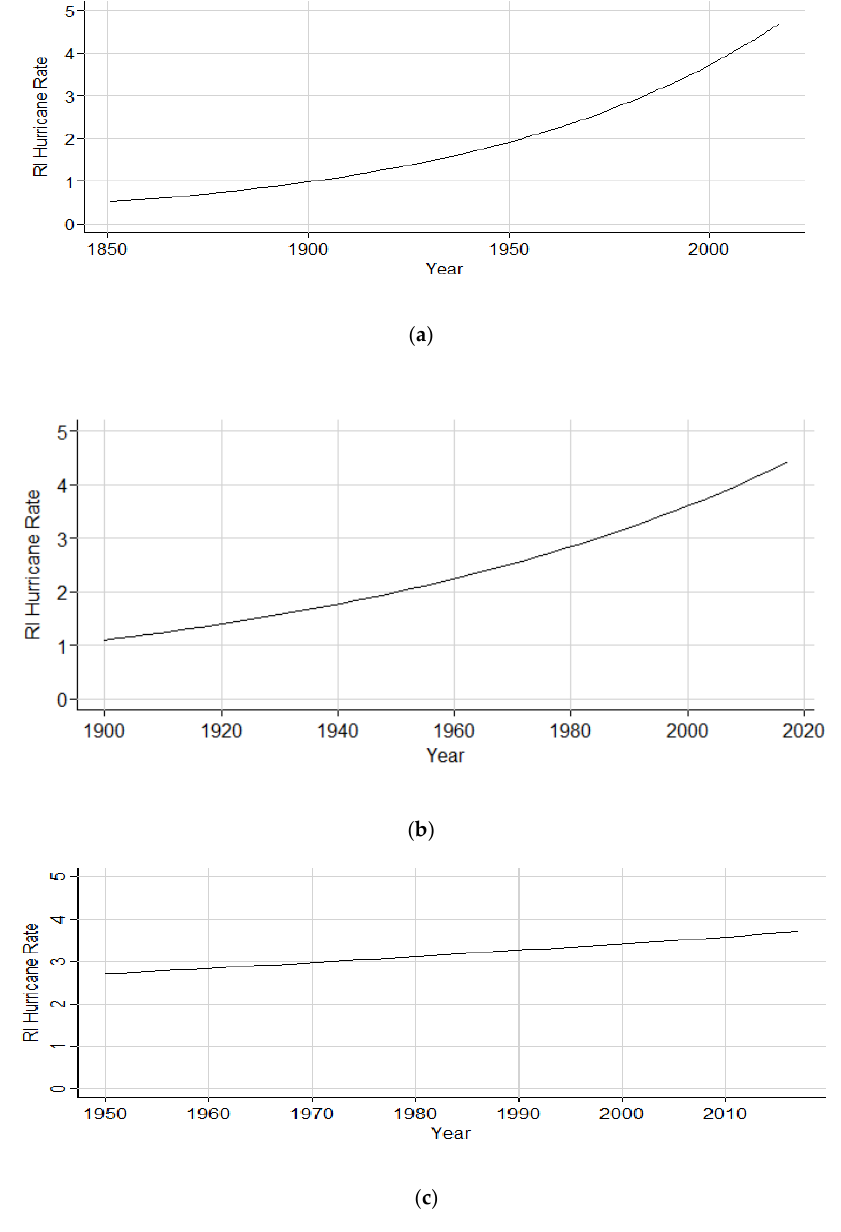
Figure 7. Incidence rate ratios of RI storms originating within the North Atlantic sub-basin over time described by the Poisson regression model ( a ) between 1851 – 2017 and ( b ) depicting 1900 – 2017 and ( c ) a 0.4% factor increase from 1950 to 2017. Table 5. Coe ffi cient estimates, p -values, and chi-square p -values on the residual deviance for RI storms originating within the North Atlantic